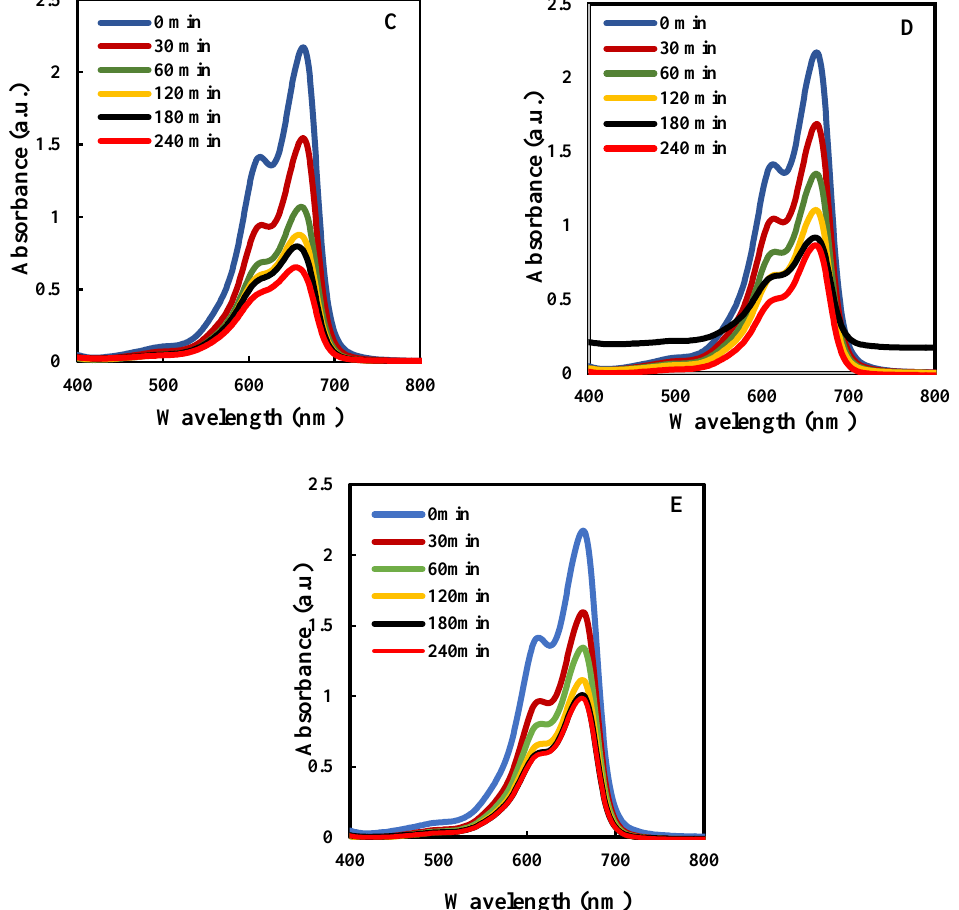
Figure 4: UV-Vis absorption spectra of photodegradation of MB dye (10 ppm) by ZnO/ sawdust /epoxy nanocomposite with different ratios of ZnONPs (A) 0.1 (B) 0.3 (C) 0.5 (D) 0.7, and (E) 1 vol.%, respectively .